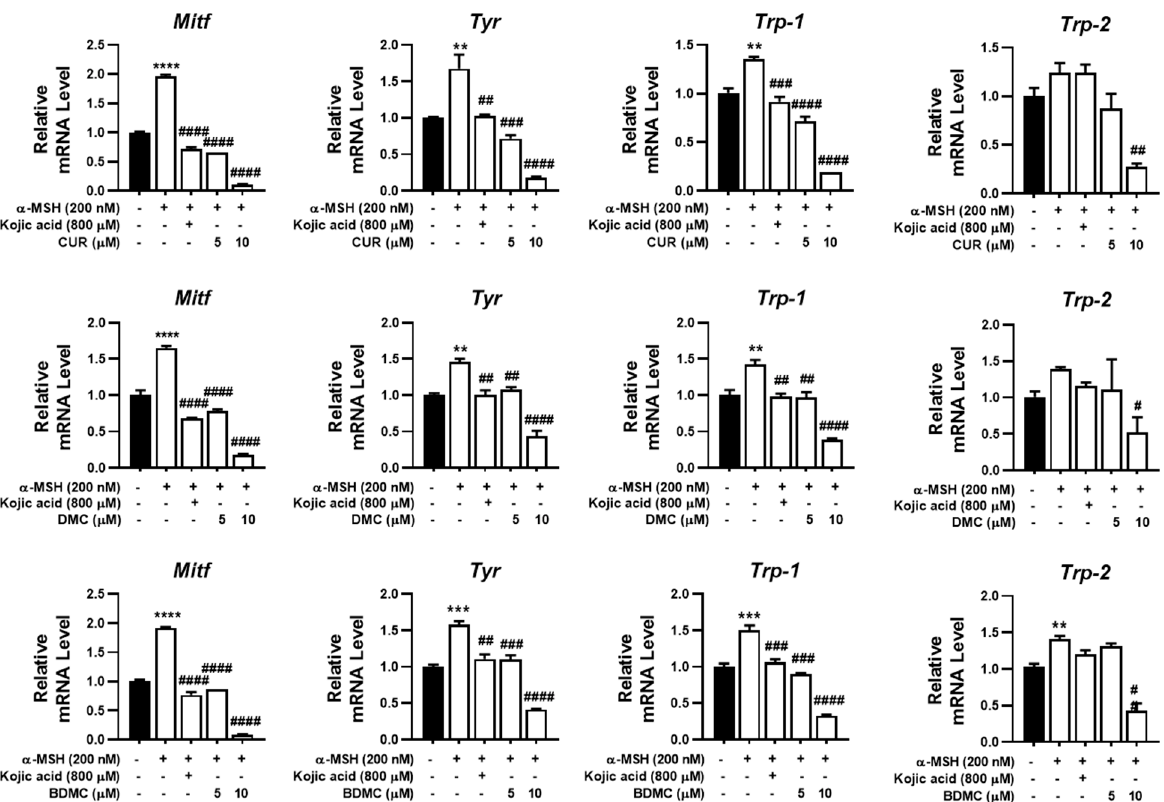
Figure 3. Effect of curcumin, dimethoxycurcumin, and bisdemethoxycurcumin on mRNA level of melanin-biosynthesis-related genes in B16F10 cell line using RT-qPCR. α -MSH, α -melanocyte stimulating hormone; Mitf , microphthalmia-associated transcription factor; Tyr , tyrosinase; Trp-1 , tyrosinase-related protein 1; Trp-2 , tyrosinase-related protein 2. Data are shown as means ± standard deviations (SDs). Significant differences are expressed by the symbols **, ***, ****, #, ##, ###, and #### as ** p < 0.01, *** p < 0.001, and *** p < 0.0001 compared with control, respectively. # p < 0.05, ## p < 0.01, ### p < 0.001, and #### p < 0.0001 compared with the α -MSH-treated group, respectively.